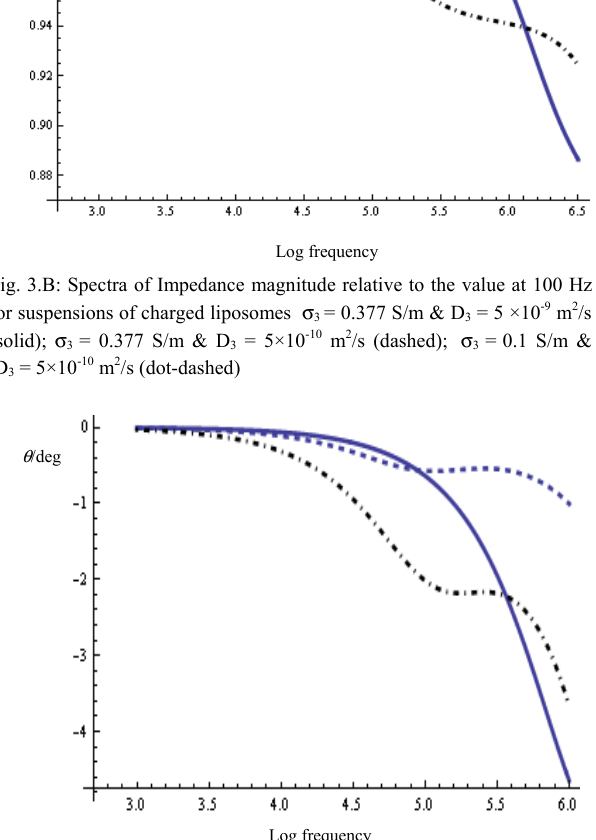
Log Fig. 3.C: Phase Spectra for suspension of charged liposomes σ 3 = 0.377 S/m & D 3 = 5×10 -9 m 2 /s (solid); σ 3 = 0.377 S/m & D 3 = 5×10 -10 m 2 /s (dashed); σ 3 ~ 0.1 S/m & D 3 = 5×10 -10 m 2 /s (dot-dashed)